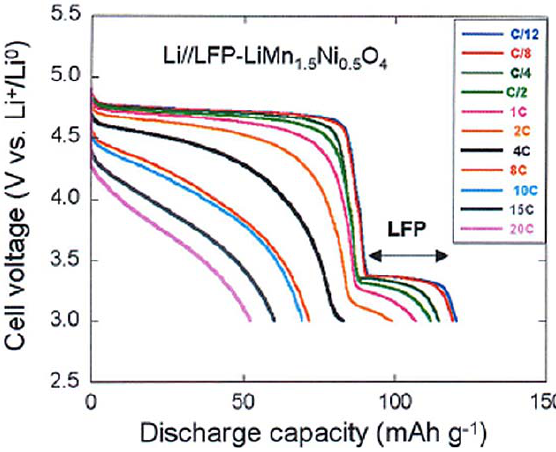
Figure 8. Discharge profiles of the Li//C-LiFePO C rates. (Reprinted with permission from [66]. Copyright 2012 Elsevier.)